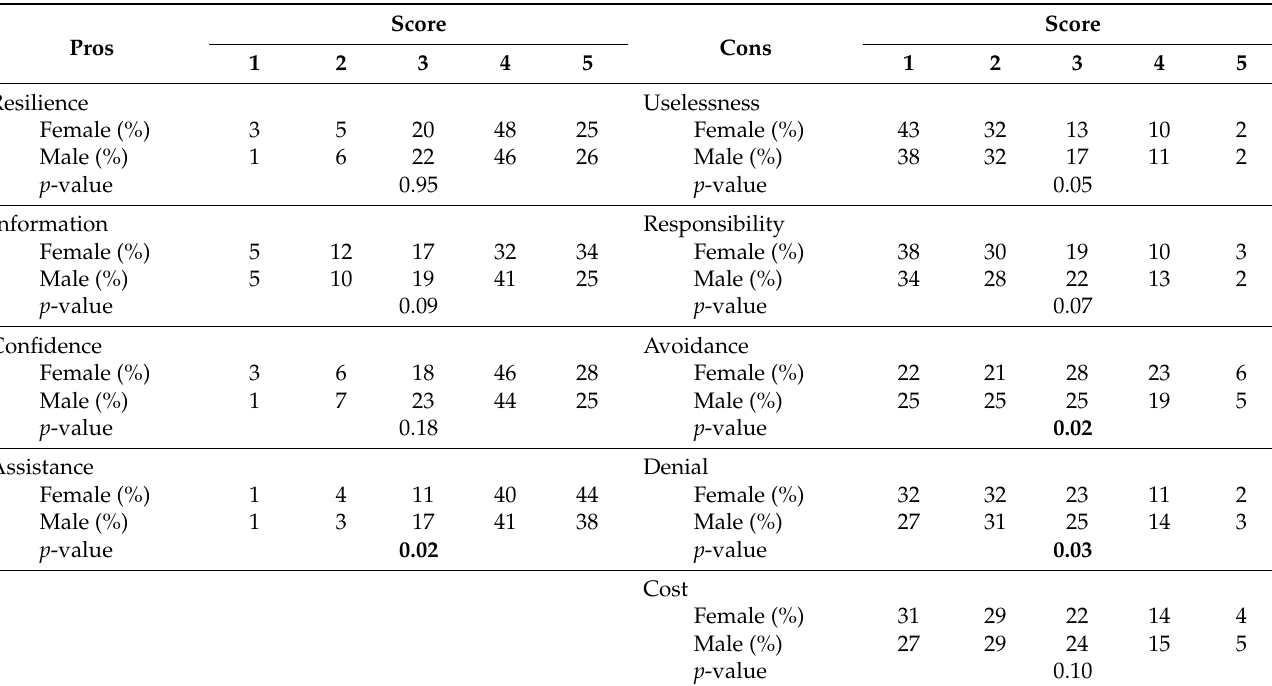
Table 6. Respondents’ reactions to the Pros and Cons of disaster preparedness (from 1 = strongly disagree to 5 = strongly agree). p -values of the two-sided Wilcoxon rank sum test. The significant p -value is in bold.